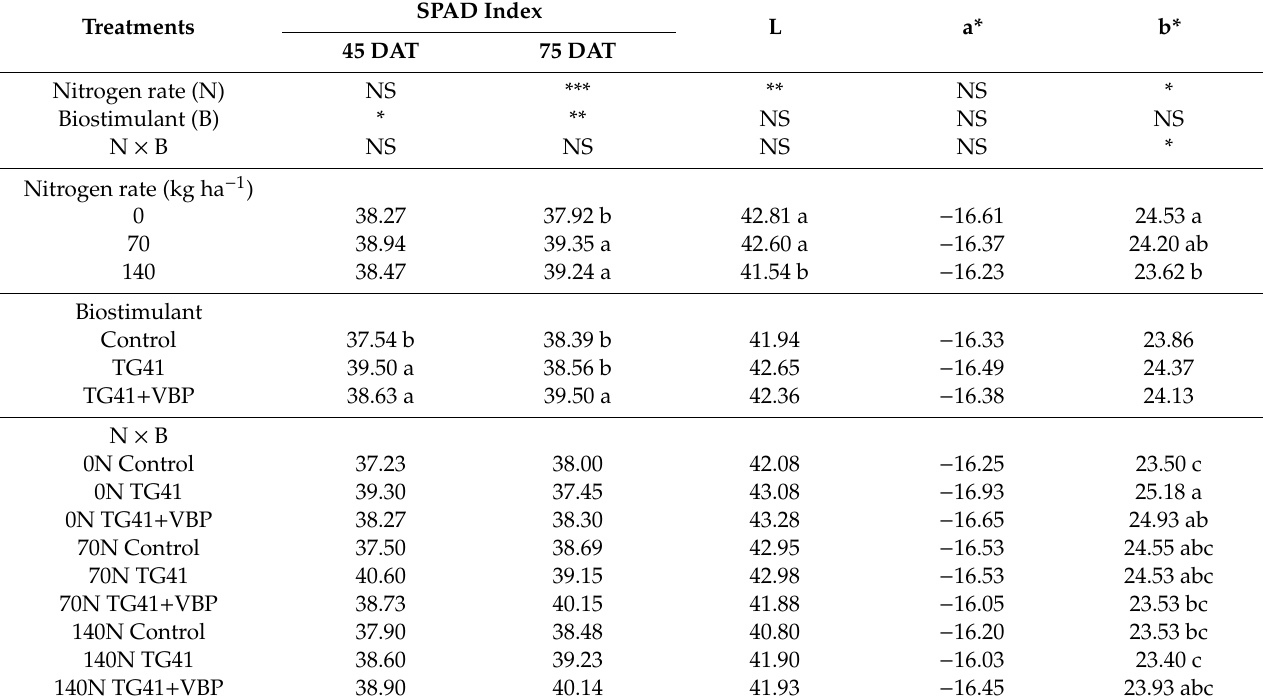
Table 1. E ff ects on Romaine lettuce soil plant analysis development (SPAD) index and Commission Internationale de L’Eclairage (CIE) color space parameters for: L* (lightness) and chroma coordinates: a* ( − a* greenness) and b* ( + b* yellowness) in relation to N fertilization level (0N = 0 kg ha − 1 , 70N = 70 kg ha − 1 , 140N = 140 kg ha − 1 ) and biostimulant application (Untreated = Control, TG41 = T. virens G41, and TG41 + VBP = vegetal biopolymer-based biostimulant) during the cultivation